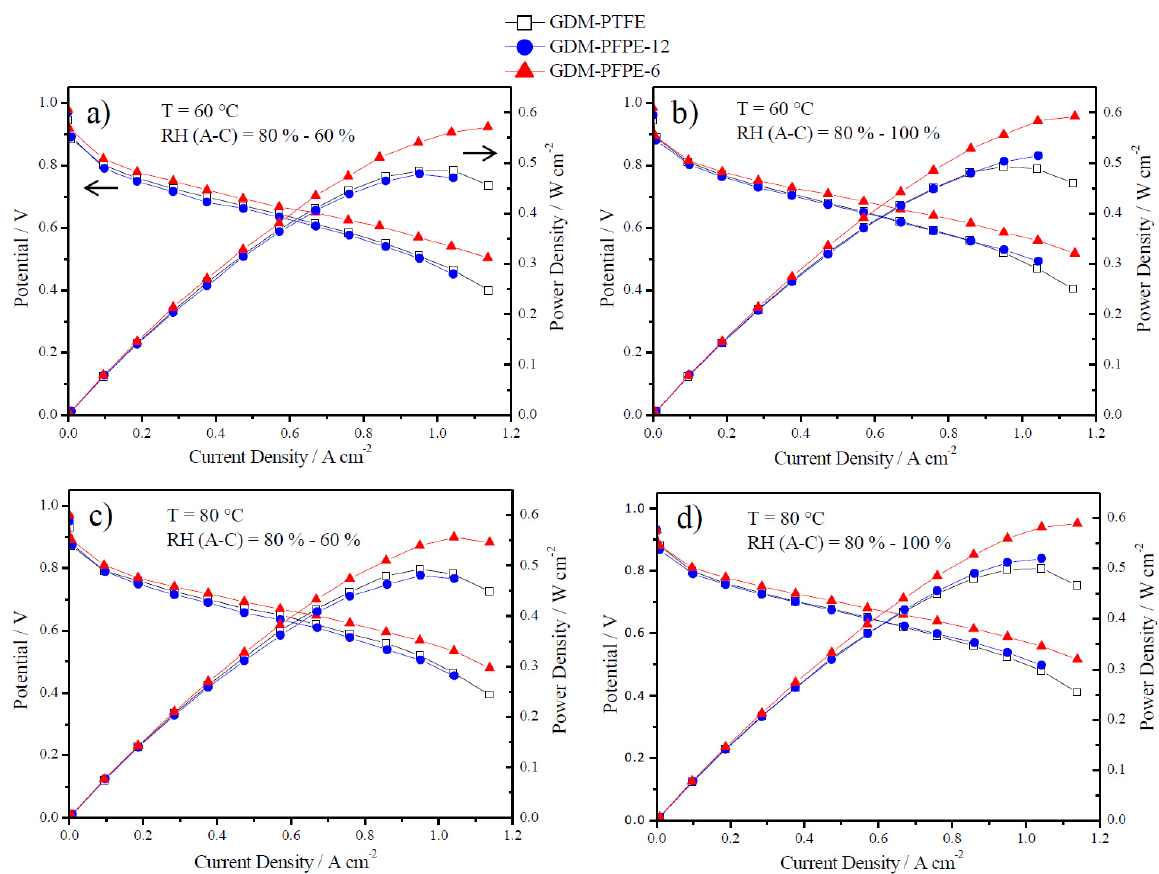
Figure 4. Polarization curves obtained at: ( a ) T = 60 °C and RH (A-C) = 80%–60%; ( b ) T = 60 °C and RH (A-C) = 80%–100%; ( c ) T = 80 °C and RH (A-C) = 80%–60%; ( d ) T = 80 °C and RH (A-C) =